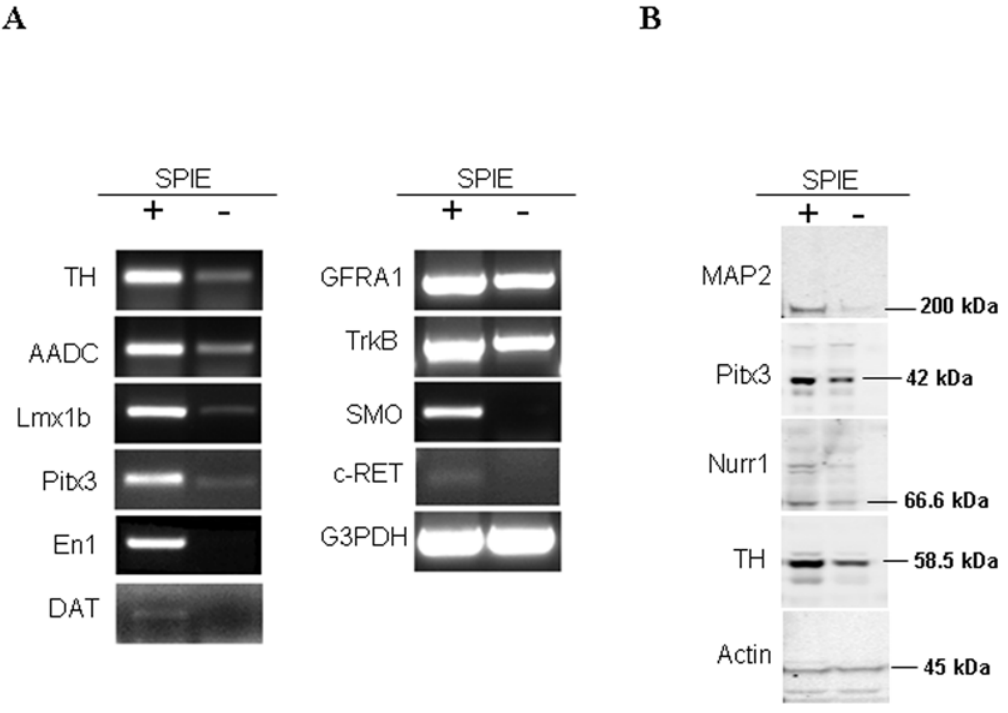
Figure 5. RT-PCR and western blot analysis of SPIE treated cultures. (A) Comparative RT-PCR results showing the effect of SPIE treatment on differentiation of BG01V2 cells to midbrain-specific DA neurons after 17 days, as confirmed by increased expression of TH, AADC, Lmx1b, Pitx3, En1, DAT and receptors including GFR1, TrkB, SMO, and c-RET. GAPDH was amplified under the same conditions (35 cycles) as an internal control. (B) Western blot analysis illustrating the increased levels of MAP2, Pitx3, Nurr1 and TH proteins, as compared to untreated cultures. The housekeeping gene actin shown in the lower panel was used as an internal loading control.